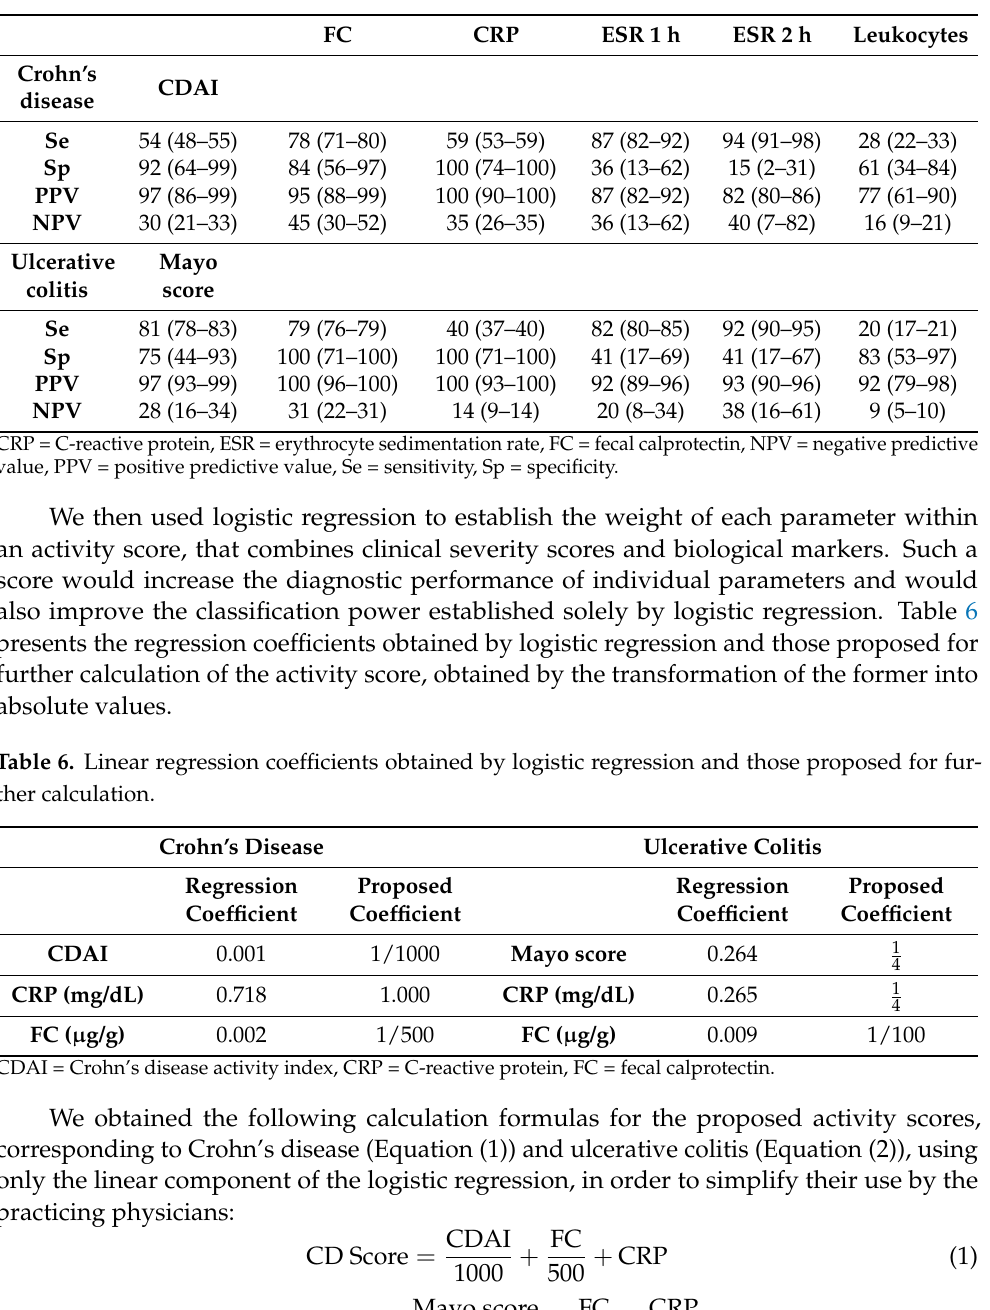
Table 5. Description of the diagnostic performance for predicting endoscopic activity of the studied parameters, for Crohn’s disease and ulcerative colitis.